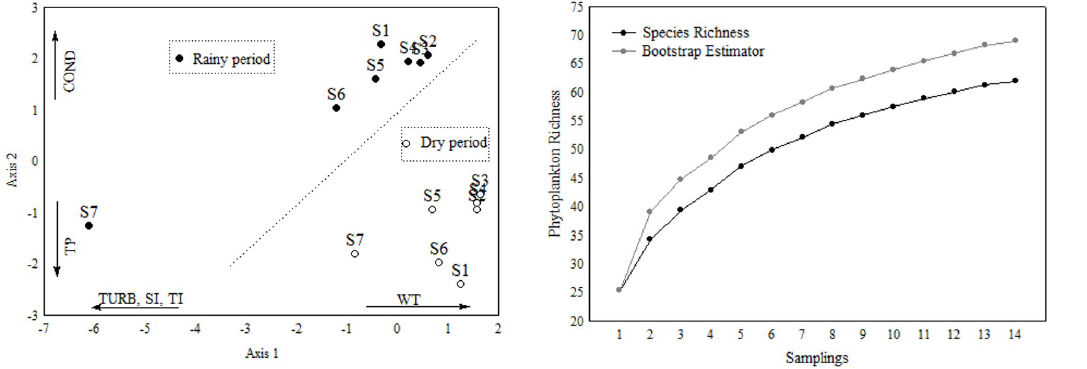
Figure 4. Species accumulation curve and Bootstrap estimator of the phytoplankton richness recorded in the João Leite reservoir, GO, Brazil, during a dry and rainy